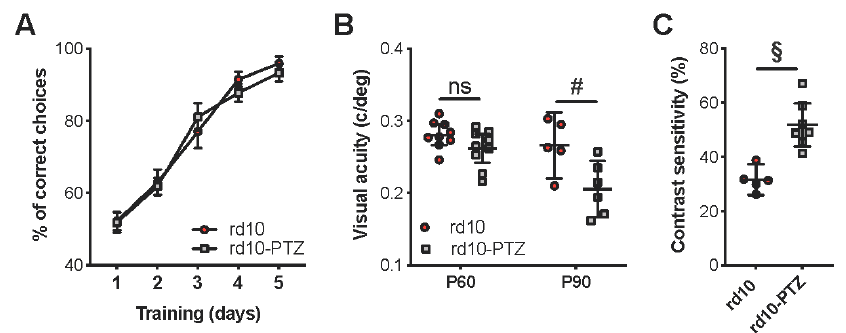
Figure 6. Antagonizing GABA neurotransmission in rd10 adult mice deteriorated visual acuity and contrast sensitivity. ( A ) Percentage of correct choices during the training phase of the visual water task in rd10 animals treated with the vehicle solution (red circles; rd10) or the PTZ drug (grey squares; rd10-PTZ). Three sessions of 10 trials were performed every day. The learning timeline of the two experimental groups was totally comparable (two-way RM ANOVA, treatment factor p = 0.761). Data are expressed as mean ± s.e.m. ( B ) Behavioral visual acuity of rd10 and rd10-PTZ animals plotted for age groups. A two-way ANOVA showed a significant effect of age and treatment ( p < 0.01). Post-hoc Holm–Sidak test revealed a significant difference at P90 (rd10, n = 5 and rd10-PTZ, n = 6; p < 0.01), whereas PTZ did not significantly affect visual acuity at P60 (rd10, n = 9 and rd10-PTZ, n = 9; p = 0.313). Symbols represent single data values, and black lines indicate mean with 95% CI. ( C ) Contrast sensitivity significantly declined with PTZ treatment in rd10 mice at P90 (rd10, n = 5 and rd10-PTZ, n = 7; t -test, p < 0.001). Symbols represent single data values, and black lines indicate mean with 95% CI. # p < 0.01, § p < 0.001, and ns: not significant.